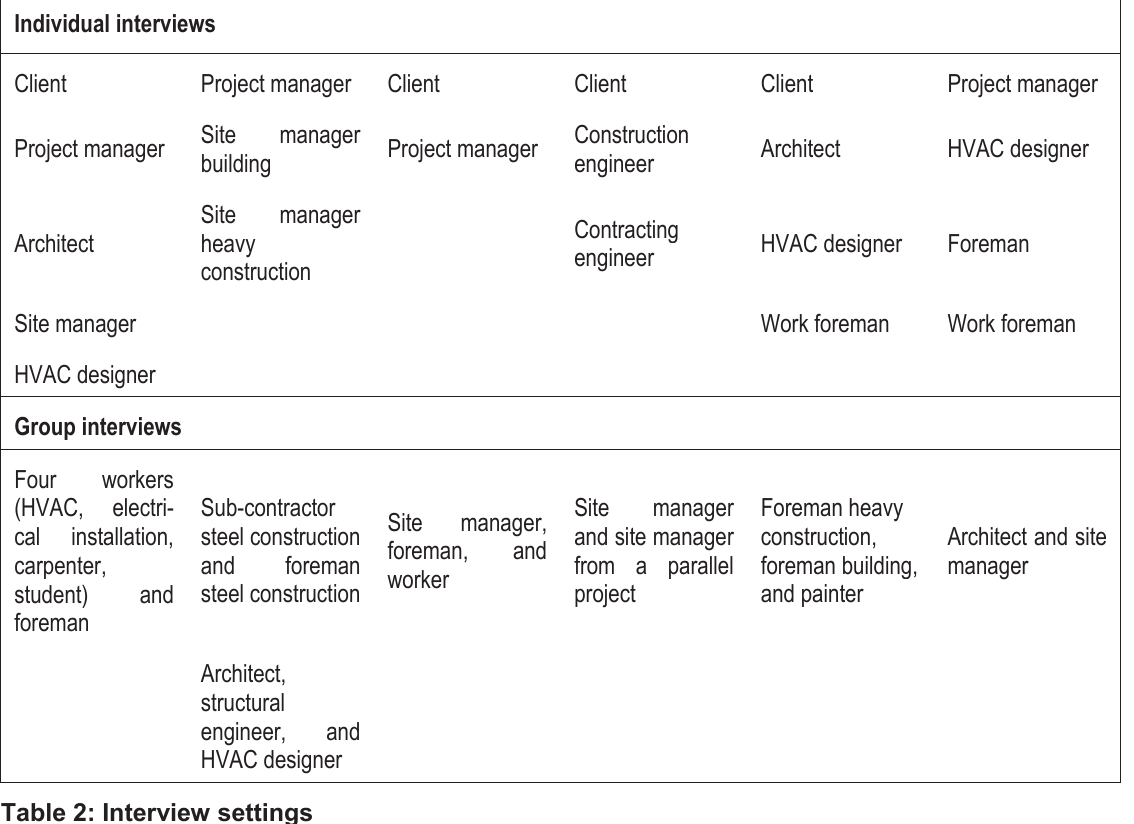
53 The Australasian Journal of Construction Economics and Building [Vol 8, No